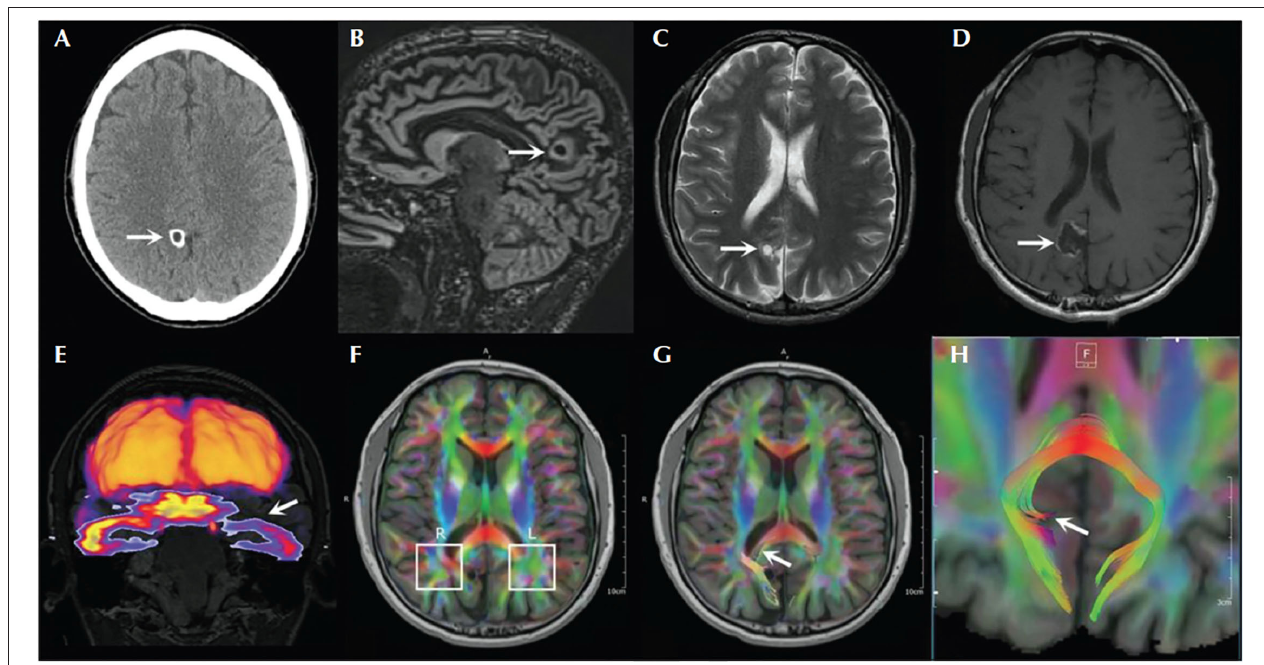
FIGURE 1 | Brain imaging of the patient with right precuneus neurocysticercosis and left temporal lobe seizure involvement. (A) Head CT showing calcified lesion in the right precuneus. (B) Double inversion recovery MRI showing the lesion with surrounding gliosis. (C) T2-weighted image showing the lesion. (D) Postoperative MRI T1 sequence showing the cavity. (E) Coregistration of FDG-PET with MRI showing hypometabolism in the left temporal lobe. (F–H) Diffusion tensor imaging through the level of the lesion showing asymmetrical findings with respect to the parietal white matter [adapted from (